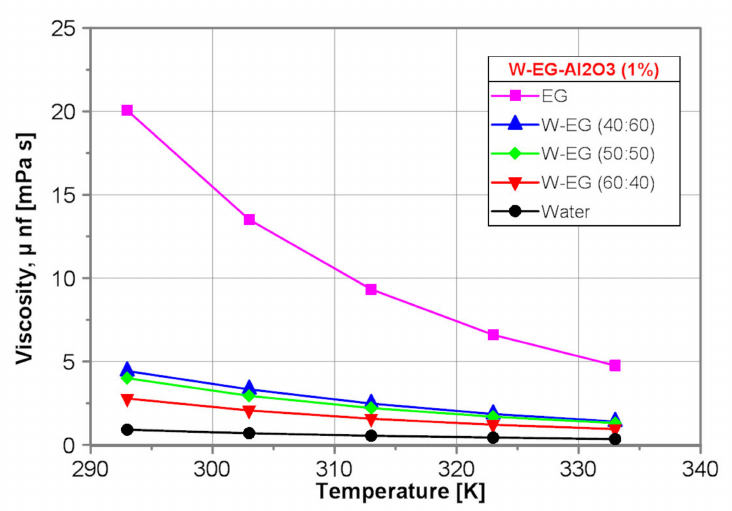
Figure 4. Dynamic viscosity of the tested nanofluids.